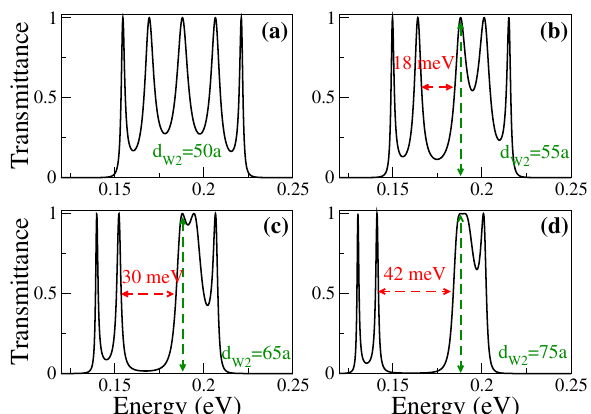
Figure 9. Main electron transmission band of BPGGSLs as a function of the energy for different d W 2 as indicated. The dashed-green vertical arrows indicate the resonance associated to the transparent state. The other superlattice parameters are the same as in Fig.